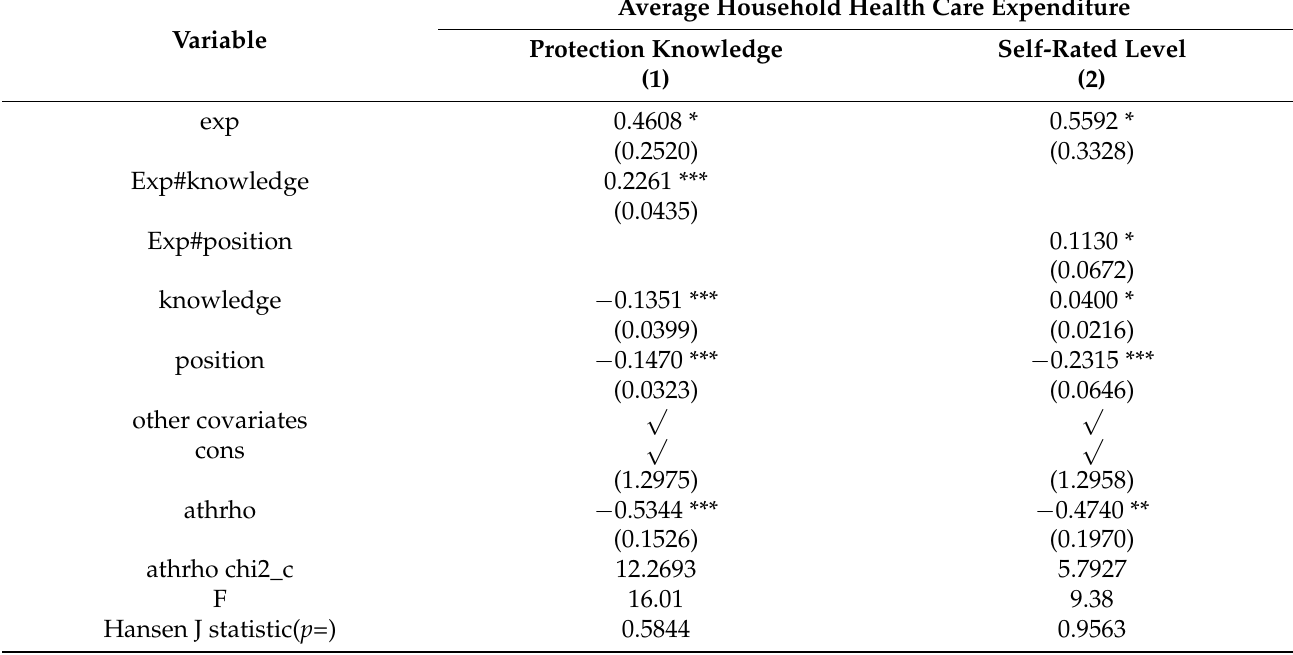
Table 7. Interaction effect of smog avoidance with information application ability and self-rated income level.